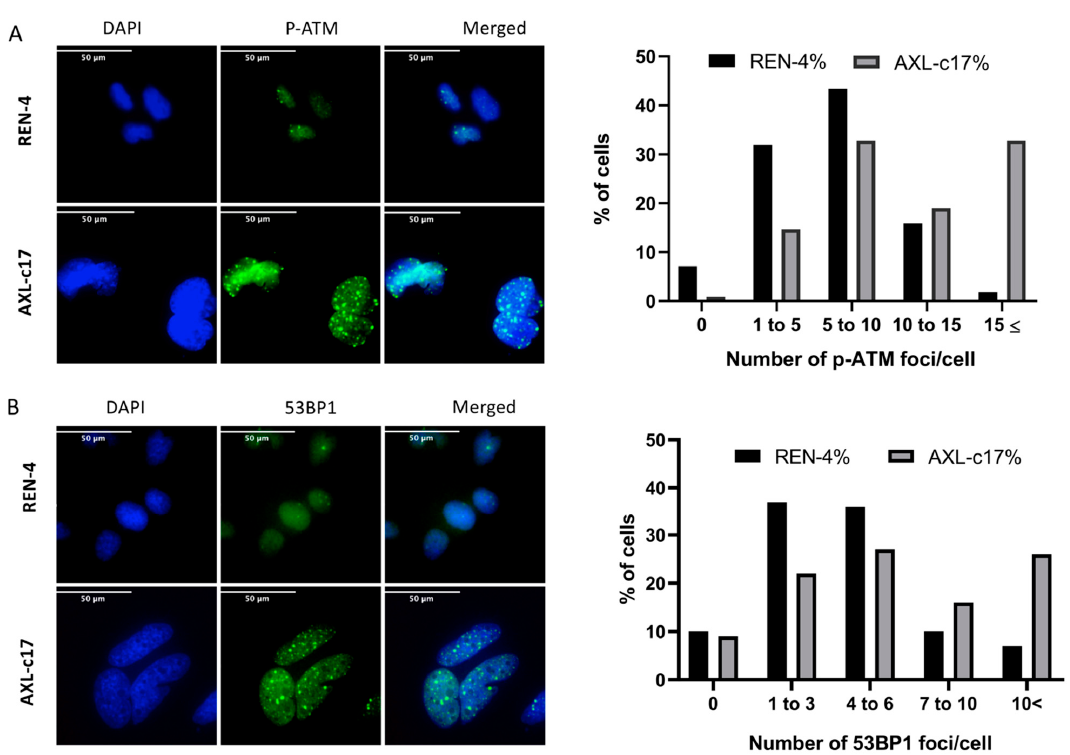
Figure 4. Foci formation as a marker of DNA damage response in AXL knock-out cells. Representative immunofluorescent image (left) and number of foci per cell distribution (right) of ( A ) p-ATM (Ser1981) and ( B ) 53BP1. Approximately 300 cells were counted for quantification. DAPI (blue) stains nucleus and foci were shown with green dots. The 53BP1 and p-ATM foci number per single cell was grouped as 0, 1–3, 4–6, 7–10, and greater than 10, and 1–5, 5–10, 10–15, and greater than 15, respectively.